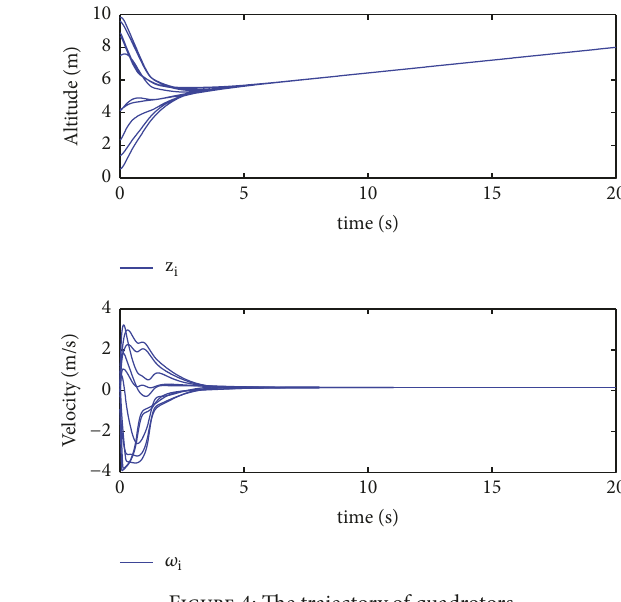
Figure 4: The trajectory of quadrotors.